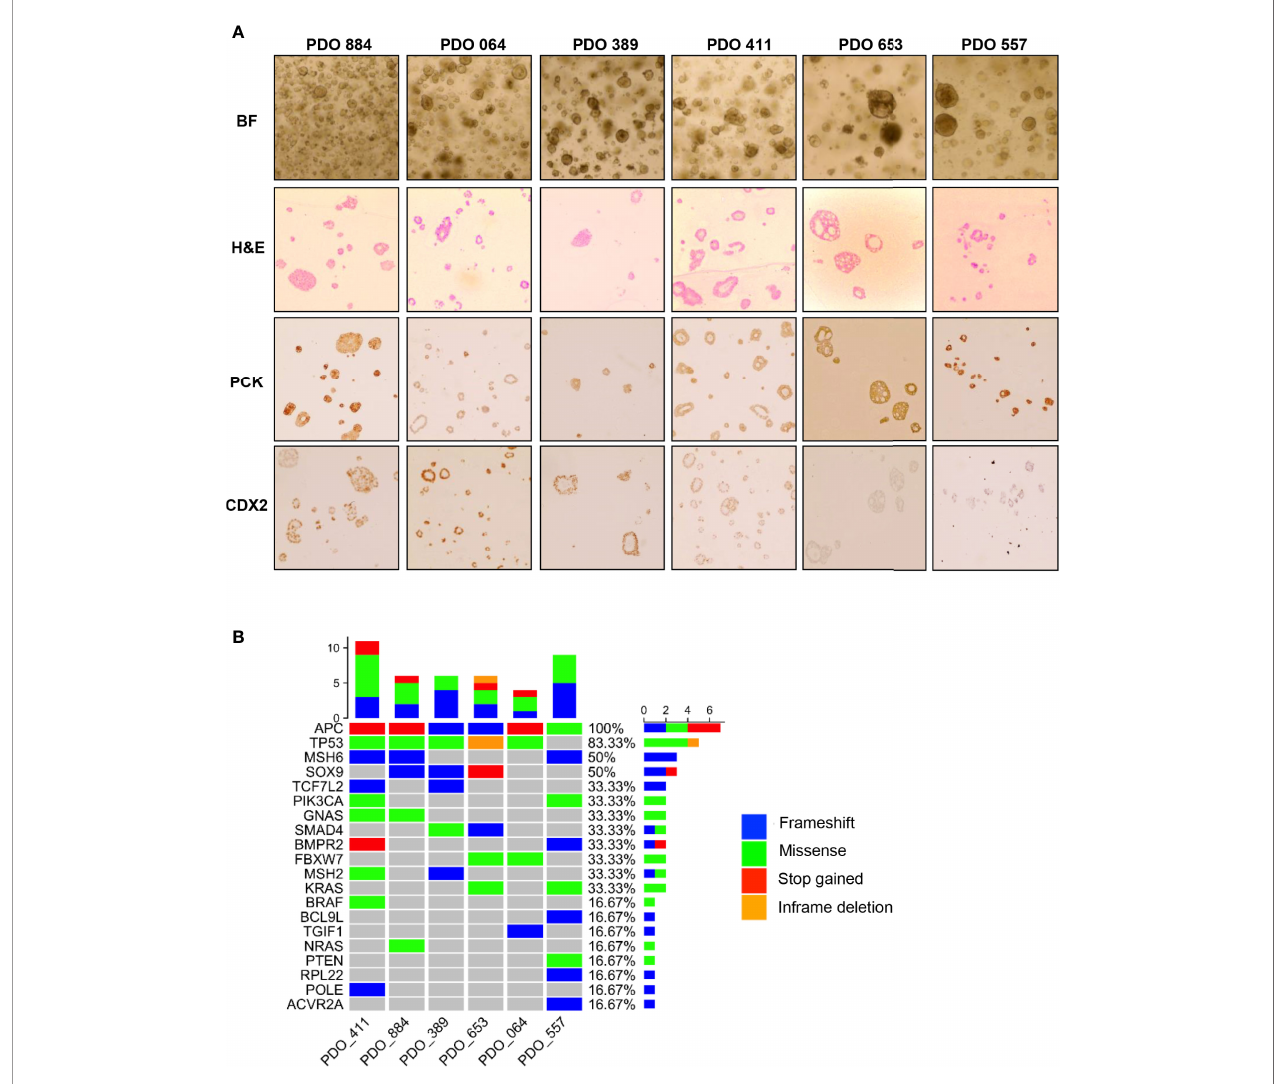
FIGURE 1 | Characterization of the patient-derived organoids used in this study. (A) Bright- fi eld microscopy (BF) imaging and H&E staining (H&E) of cultured PDOs; Immunohistochemistry staining of pan-Cytokeratin (PCK) and caudal-type homeobox 2 (CDX2) to compare staining pattern with matching primary tumours. (B) Heatmap illustrating the mutational landscape of PDO lines obtained through targeted DNA-sequencing using a panel of 30 known CRC genes (see Methods for detailed